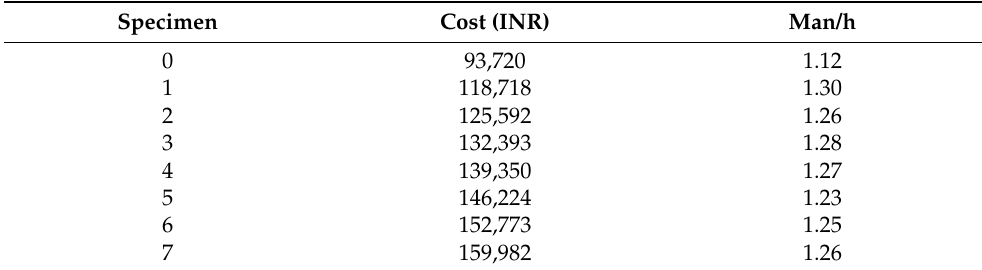
Table 5. The man/hour and cost of the sample.